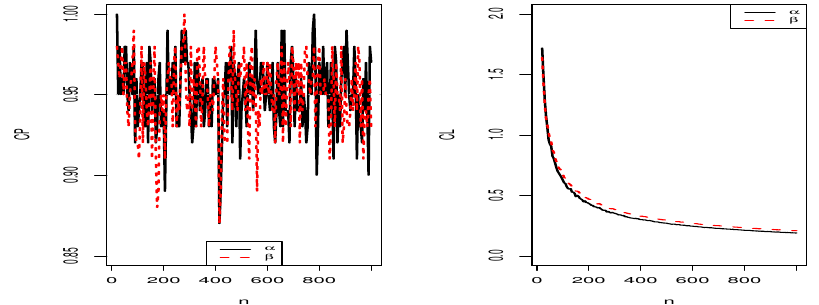
Figure 7. The empirical CLs and CPs of the MLEs for the